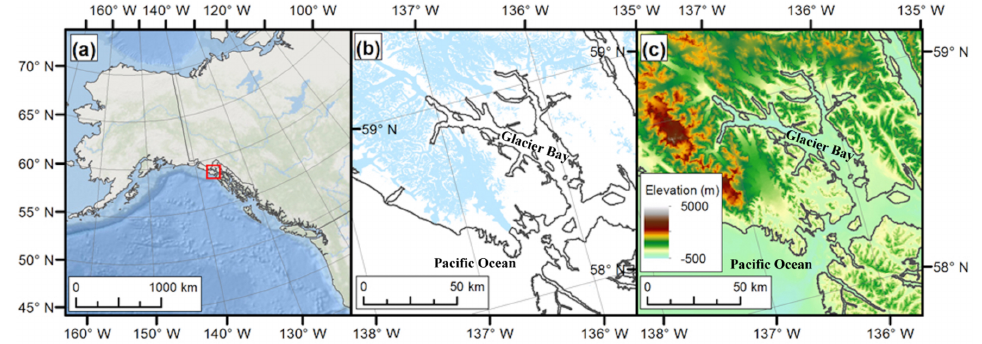
Figure 1. Study area map. (a) Overview of the northern Gulf of Alaska; red box shows extent of panels (b) and (c) . (b) Glacier cover (blue) in the Glacier Bay region from the Randolph Glacier Inventory (RGI; Pfeffer et al., 2014). (c) Bathymetry and elevation in the Glacier Bay region from the Southern Alaska Coastal Relief Model (Lim et al.,